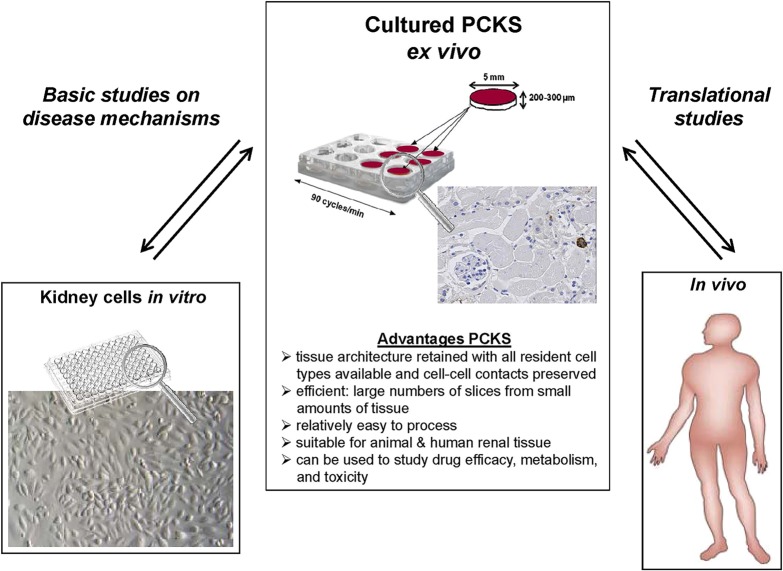
The ex vivo PCKS model bridges the gap between basic research performed in in vitro cell culture models and translational in vivo human studies on pathophysiology and therapy of renal disease.
In vitro cultured cells displayed are primary human tubular epithelial cells (PTECs).